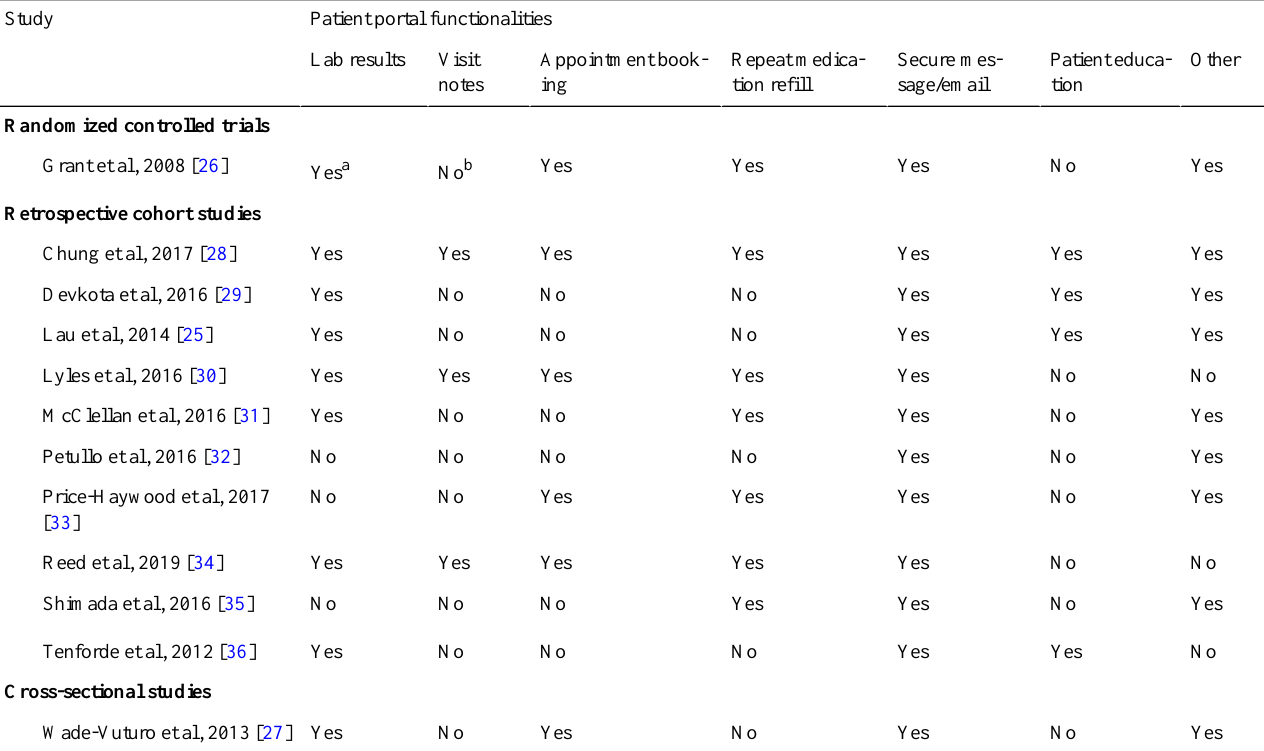
Table 1. Patient portal functionalities in the included studies. Patient portal